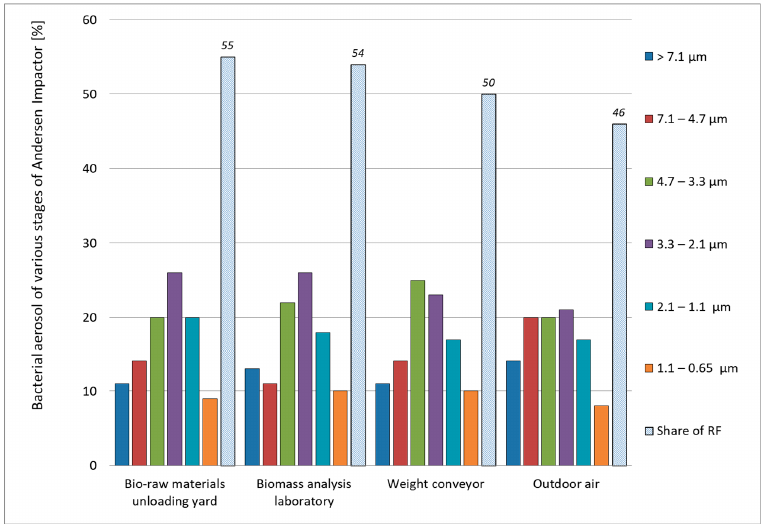
Figure 4. Particle size distribution (PSD) of bacterial aerosol in the analysed power plant.